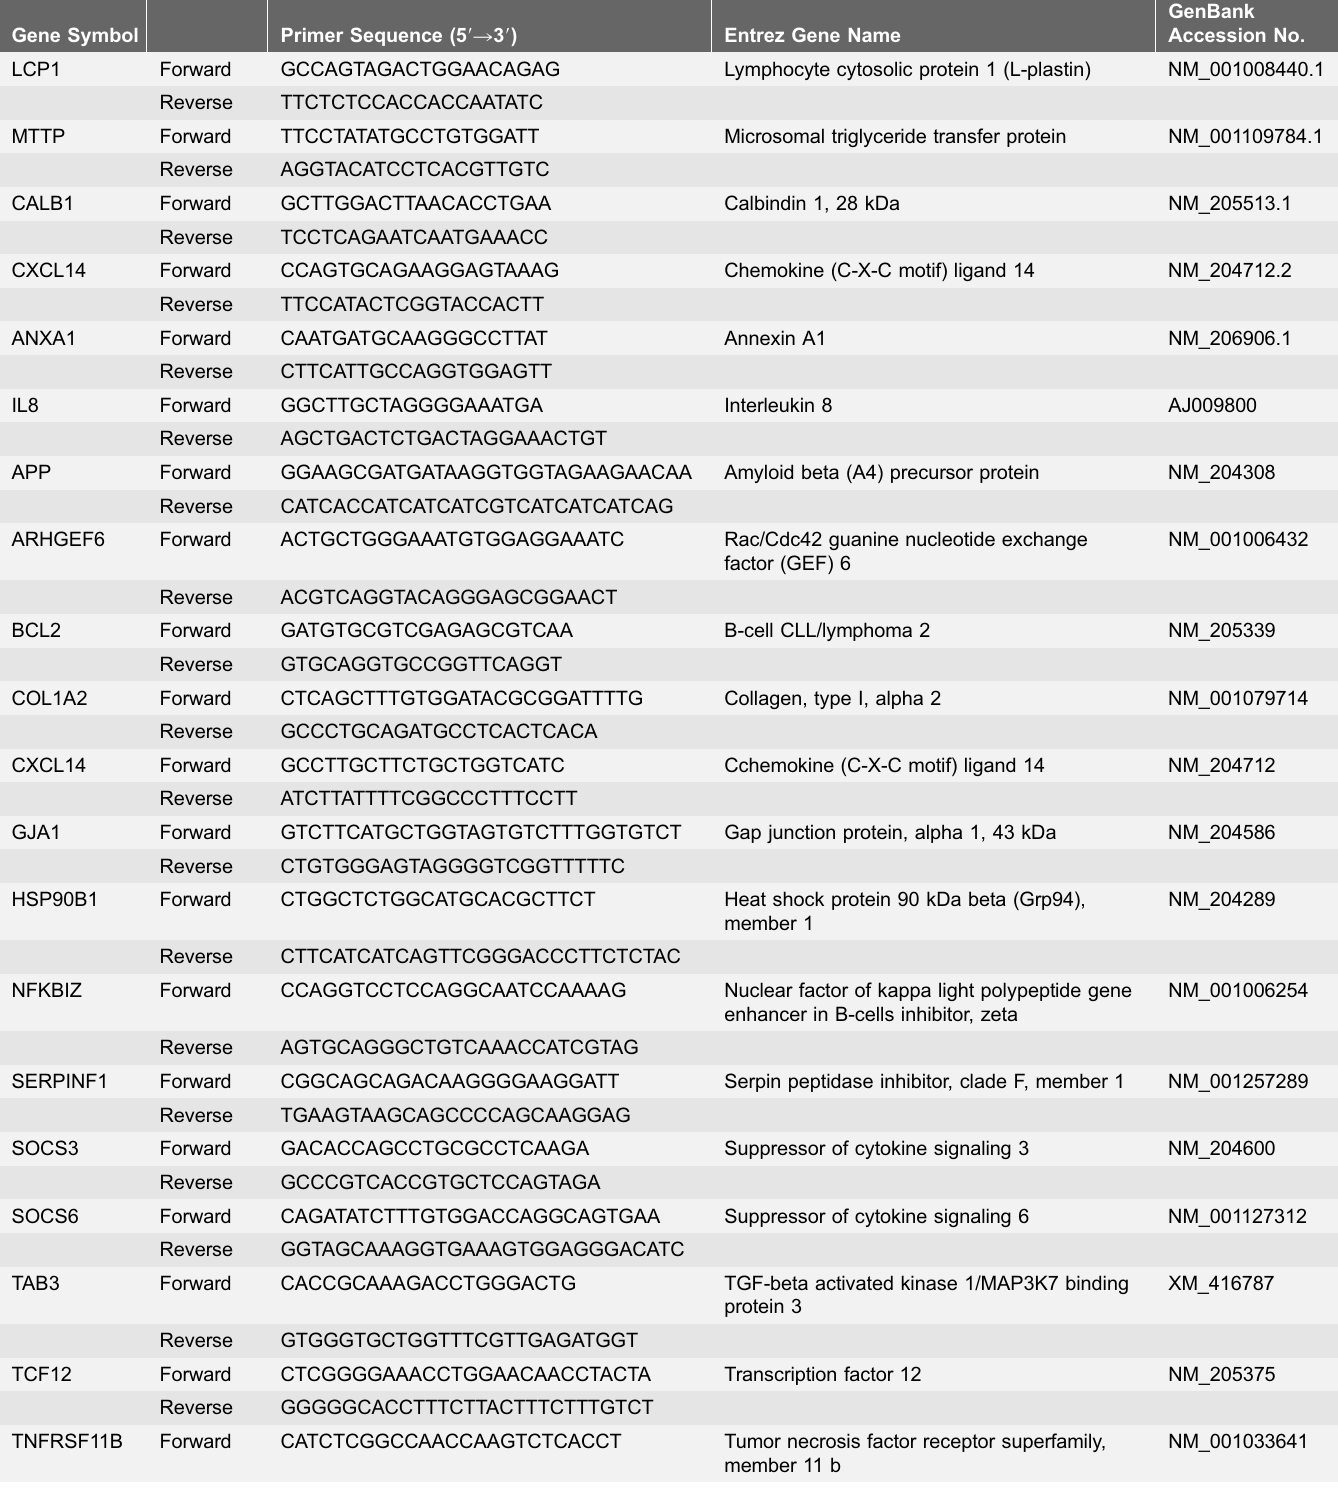
Table 1. Oligonucleotide primers used for qRT-PCR. Gene